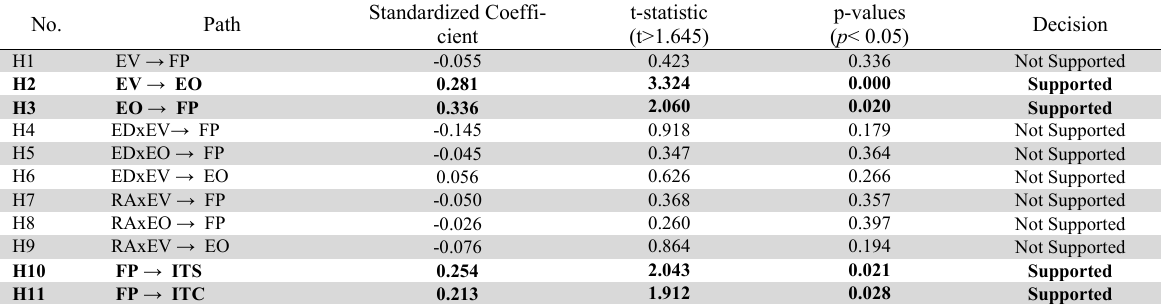
Value and Significance of Path